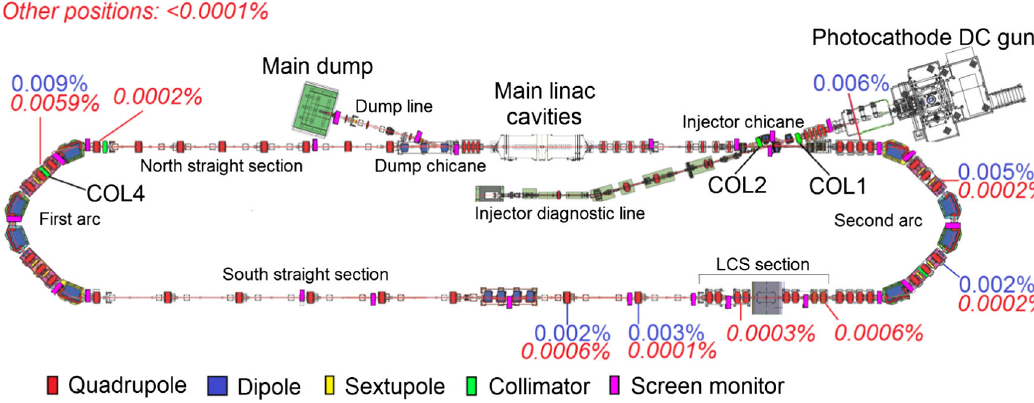
FIG. 24. Comparison of beam loss rates along the beam line for the high-current operation ( J ¼ 0 . 95 mA) where the collimators COL1, 2 and 4 are inserted in. Loss rates are given in percentage of the bunch population. Loss rates estimated from the measured secondary photons are denoted by blue numbers. Simulation results (italic red numbers) are for particles tracking with the total number of particles N ¼ 10 6 , with the Gaussian distribution of the σ ¼ 3 . 3 ps core in the presence of longitudinal bunch back and forward tails. In the simulations, all the steering coils are turned on. The measured horizontal offset of the second cavity (2.6 mm), and the common vertical offsets of the cavities nos. 1 – 3 (2 mm) are included.